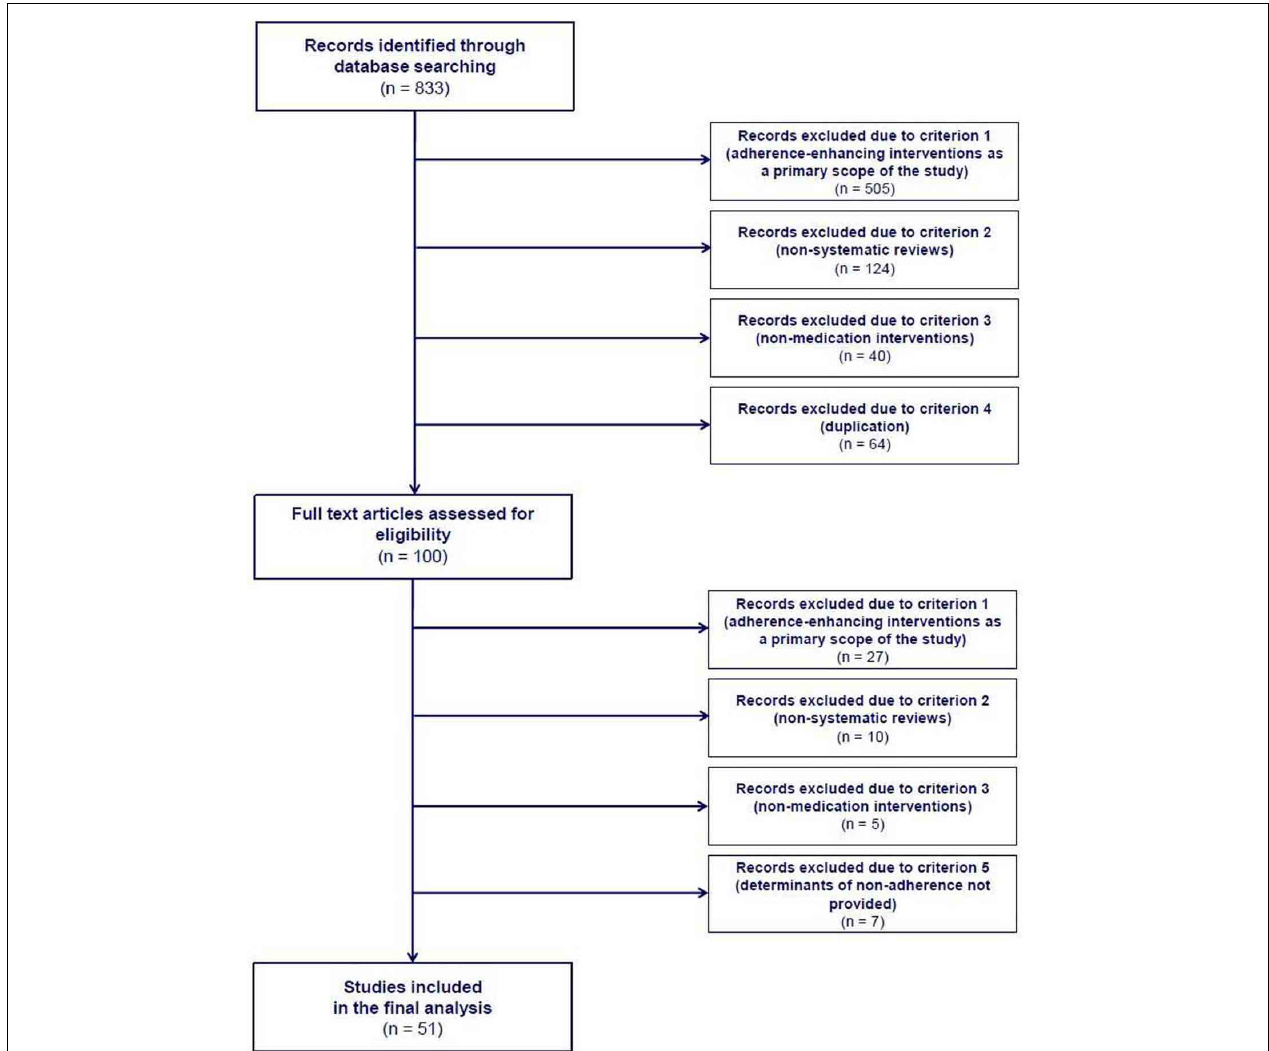
FIGURE 1 | Flow diagram of study selection